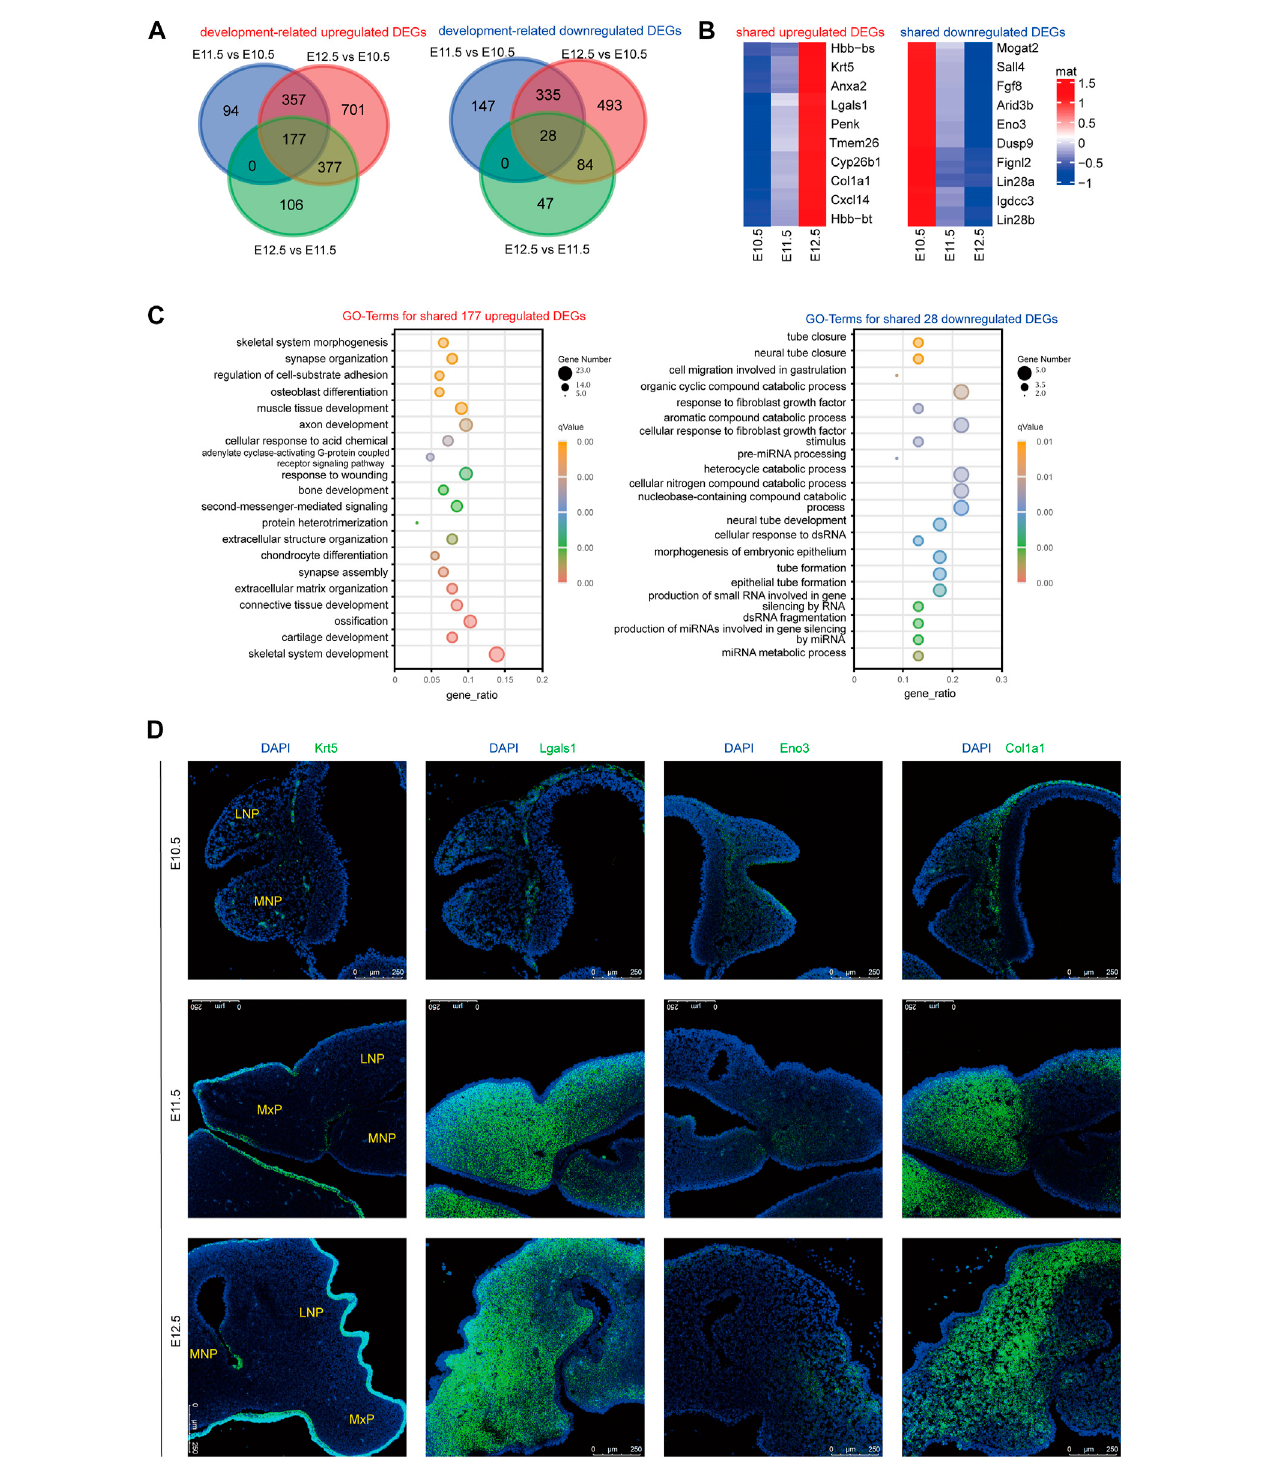
FIGURE 2 RNAScope validation of development-associated upregulated or downregulated DEGs. (A) Venn diagram showing theamount ofsharedupregulated or downregulated DEGs among comparison group E11.5 vs. E10.5, E12.5 vs. E11.5, and E12.5 vs. E10.5. (B) Heatmap showing the top ten shared upregulated or downregulated DEGs among E10.5, E11.5, and E12.5. Color key: expression levels, (C) GO terms for shared upregulated (left) and downregulated (right) DEGs from E10.5 to E12.5. (D) RNAScope analysis of the location and expression levels of candidate genes among E10.5, E11.5, and E12.5. MxP: maxillary prominence; LNP: lateral nasal; MNP: medial